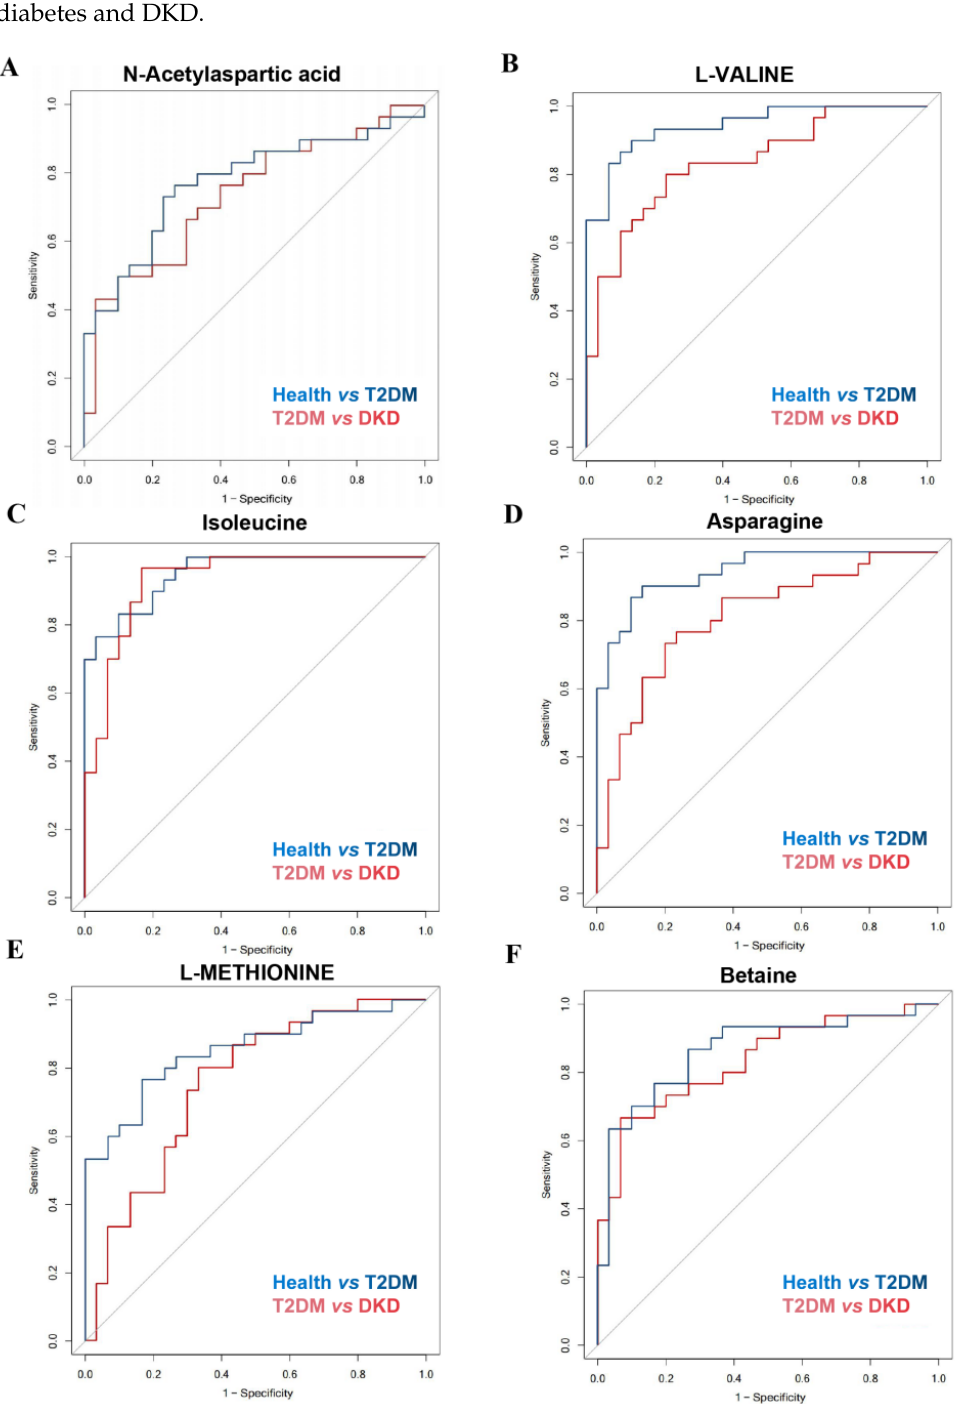
Figure 3. Discrimination ability of differential metabolites among Health, T2DM, and DKD groups. ( A – F ) ROC curves of differential metabolites for distinguishing health from T2DM patients and distinguishing T2DM patients from DKD patients. Table 3. The diagnostic power of different metabolite biomarkers in differentiating T2DM from Health controls or DKD from T2DM.